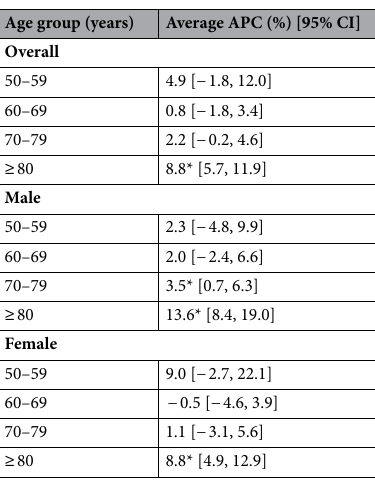
Table 1. Trend analysis in crude and age-adjusted mortality rate of Creutzfeldt–Jakob disease per 100,000 by sex and age, 2005–2014. AAR age-adjusted rate, APC annual percentage change, CI confidence interval. *Significantly different from zero ( p <